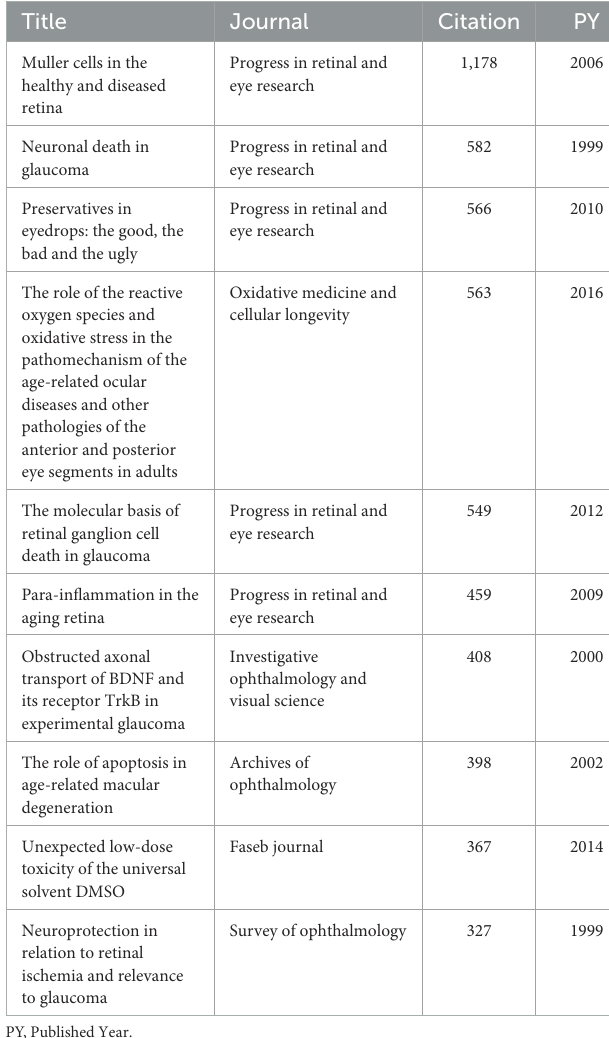
TABLE 1 The top 10 productive countries/regions.